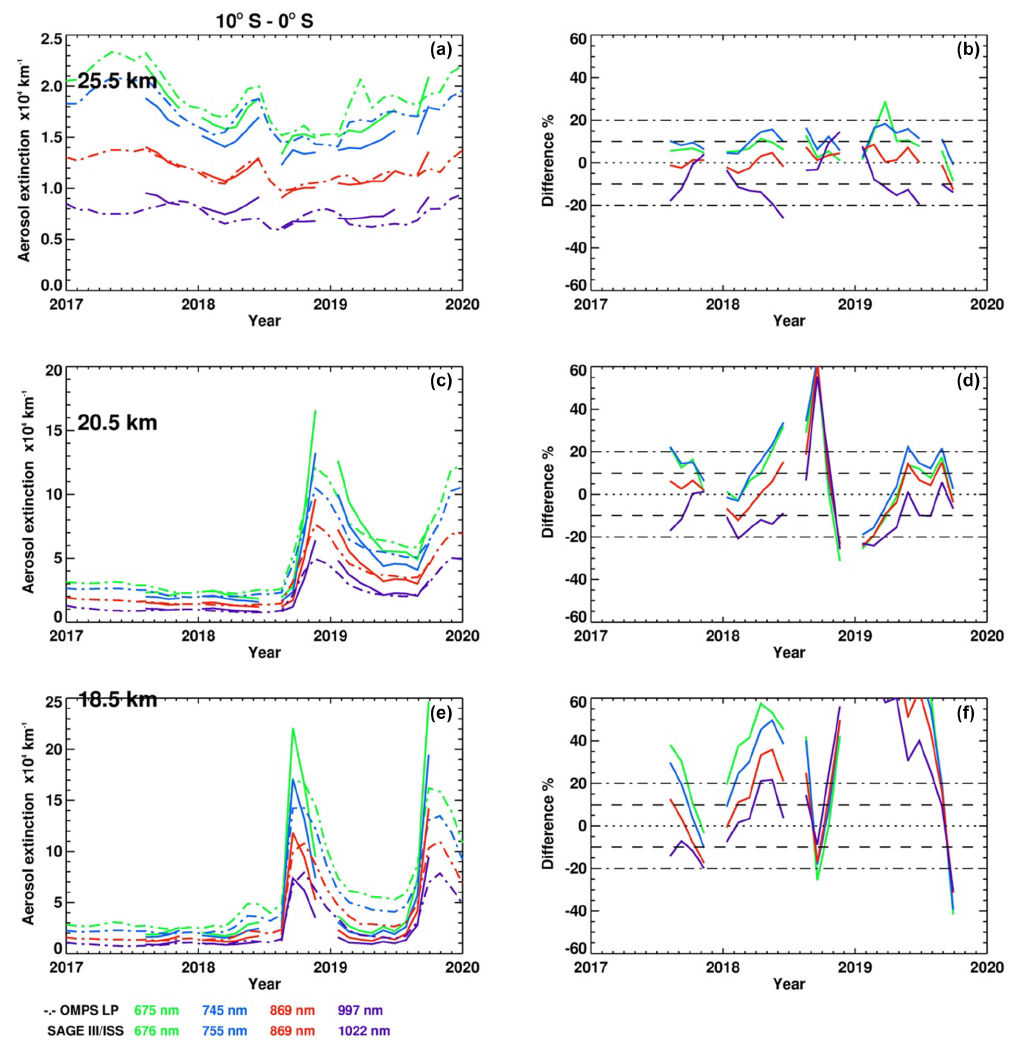
Figure 10. Same as Fig. 9 but for latitude zone 10–0 ◦